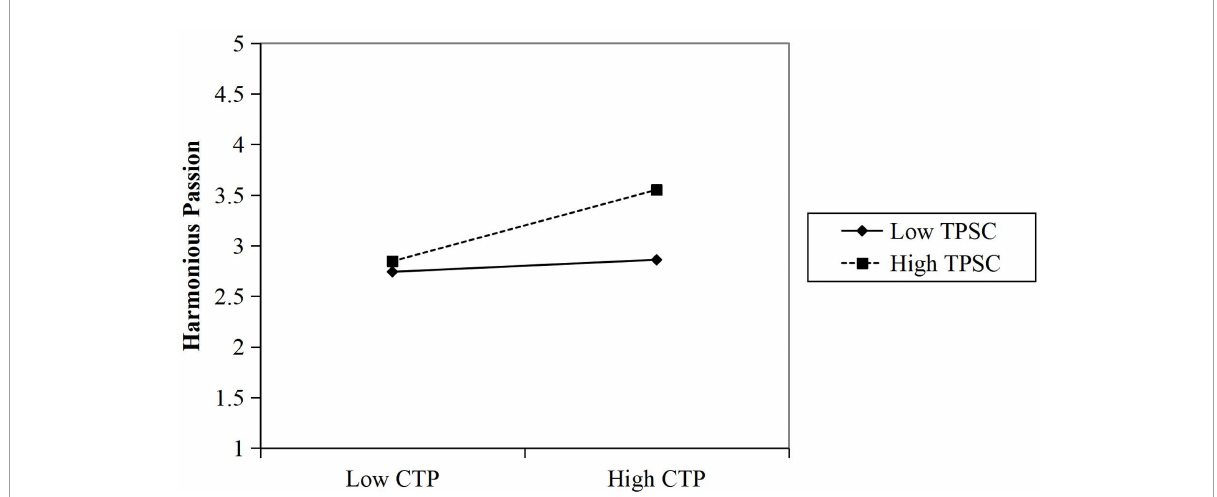
FIGURE2 The moderating effect of team psychological safety climate (TPSC) on the relationship between creative time pressure (CTP) and harmonious passion.